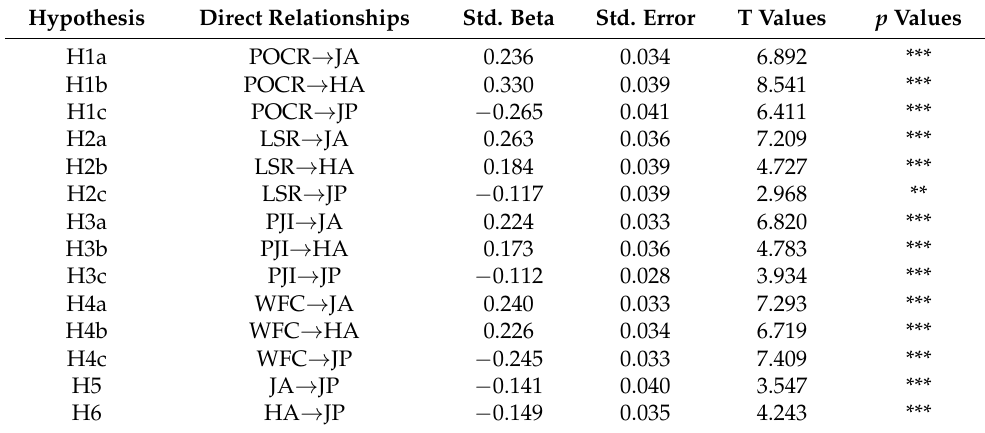
Table 8. Hypotheses testing—direct